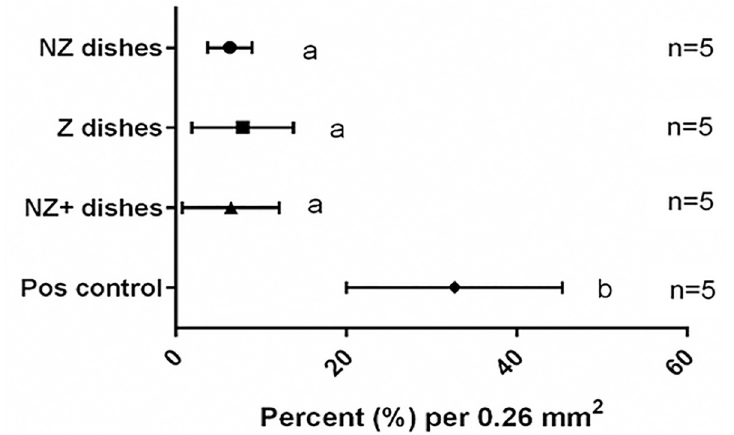
Fig 8. Early apoptosis assay results. Percentage of early apoptotic cells after two week of culture in different treatment groups (Mean ± SD). Number of replicates for each treatment group are in parentheses. Matching lowercase letters indicate the absence of statistical difference between treatments (P > 0.05). Positive control group showed significant difference (P = 5 × 10 − 13 ).